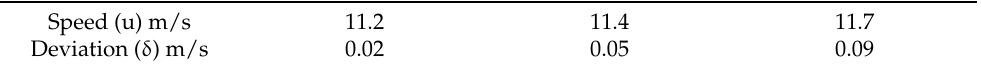
Table 1. Dependence of measured speeds on channel width from deflection δ (by results of modeling).